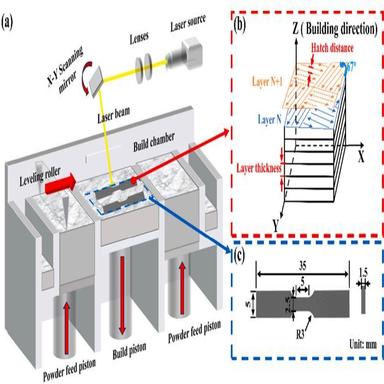
(a) Schematic diagram of LPBF processing, (b) laser scanning strategy applied in LPBF process, and (c) dimension of the LPBFed tensile testing samples.